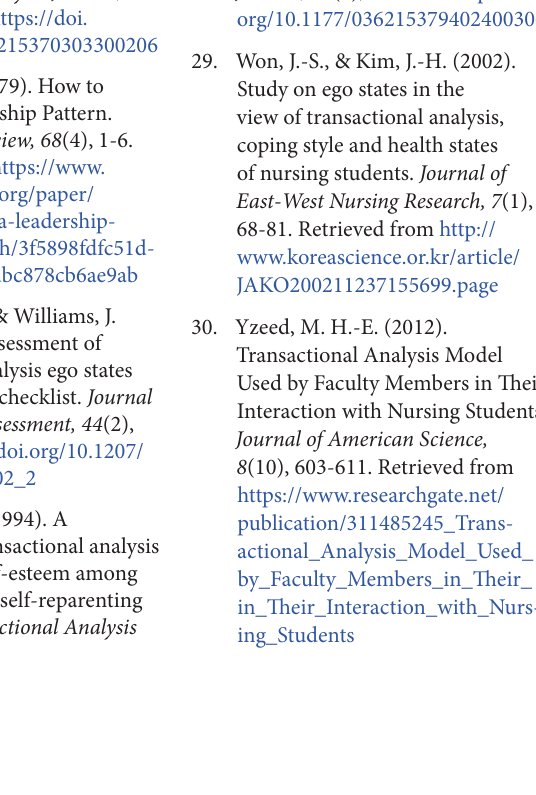
Table А1. Operating Effectiveness Quotient (OEQ)